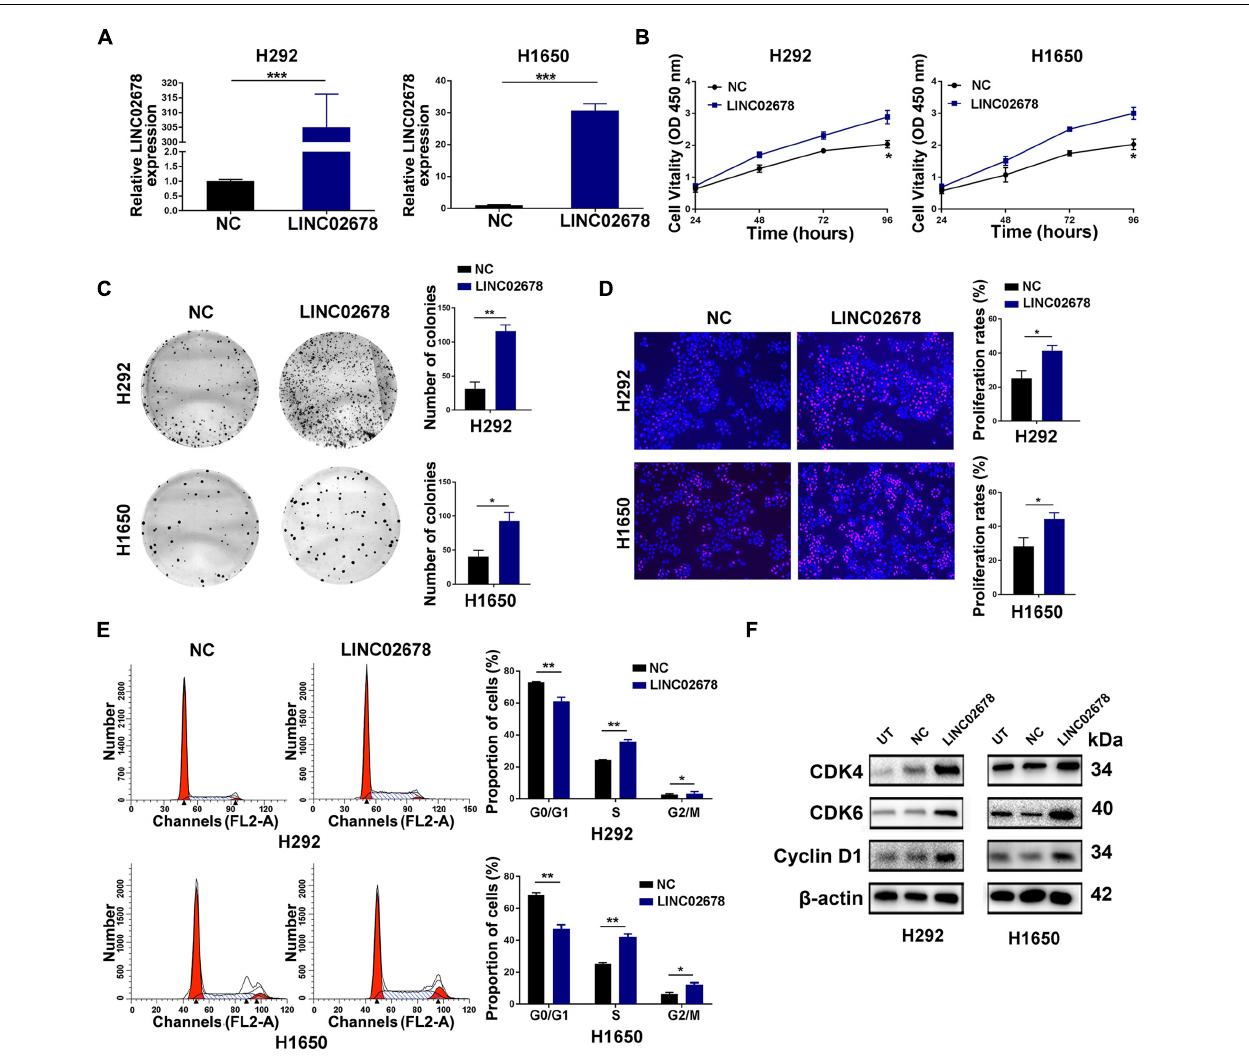
FIGURE 3 | LINC02678 promotes proliferation and G1/S transition of NSCLC cells. (A) RT-qPCR analysis showed the expression of LINC02678 in H292 and H1650 cells transfected with negative control (NC) or overexpressed LINC02678 (LINC02678) lentivirus. (B) CCK-8 analysis showed the proliferative ability of H292 and H1650 cells in NC and LINC02678. (C,D) Colony formation and EdU analysis showed the proliferative ability of H292 and H1650 cells in NC and LINC02678 groups. (E) Flow cytometry analysis showed the proportion of H292 and H1650 cells in G0/G1, S and G2/M phases in NC and LINC02678 groups. (F) Western